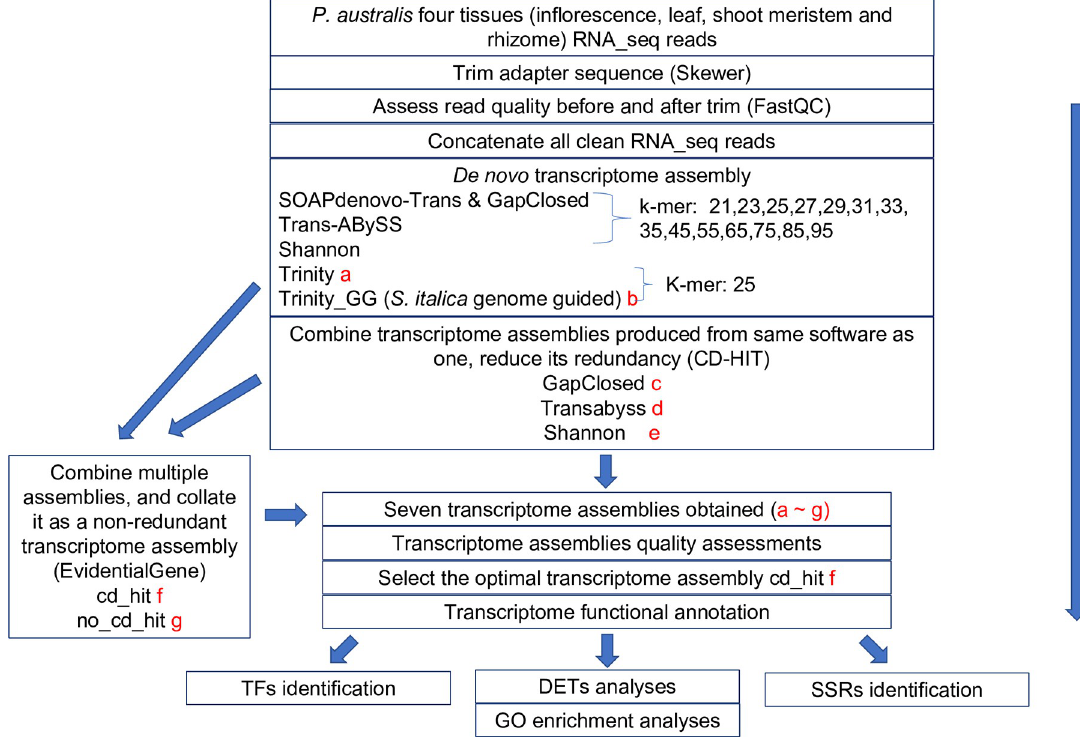
Fig 1. Experiment flowchart of transcriptome assembly and downstream analyses. Red color letters (a to g) are the selected seven transcriptome assemblies for quality assessments from forty-nine de novo assembly transcriptome assemblies.